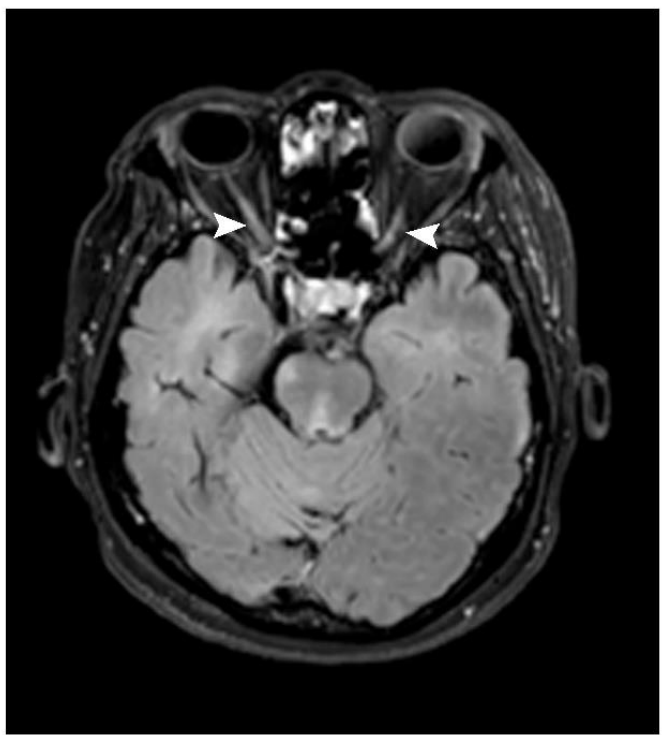
Figure 6. Axial post-contrast FLAIR image shows patchy enhancement at posterior halves of bilateral optic nerves (arrowhead) in keeping with bilateral optic neuritis.